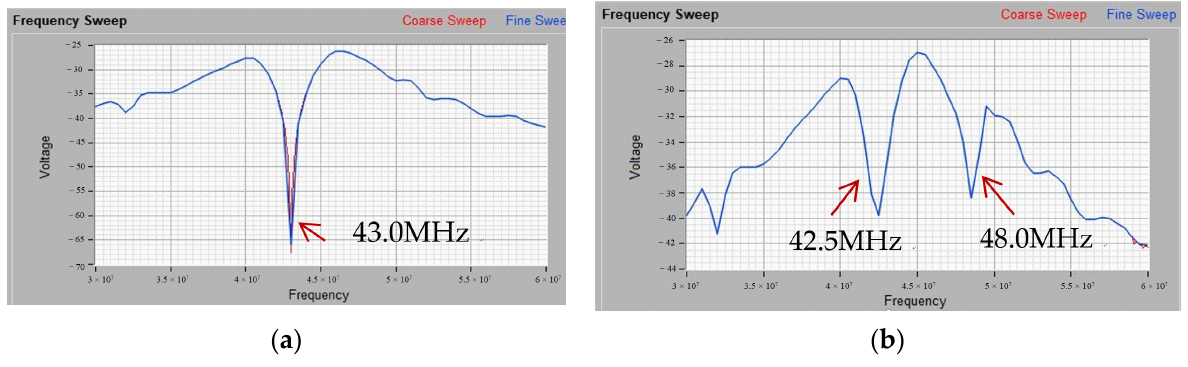
Figure 6. RF frequency sweep curve: ( a ) Reference sample; ( b ) Failed sample. The reference sample current density data were taken at 43.0 MHz, with one probe on the left side and one probe on the right side. As shown in Figure 7, the signal shows no significant decay along with the green cursor at all three modes.